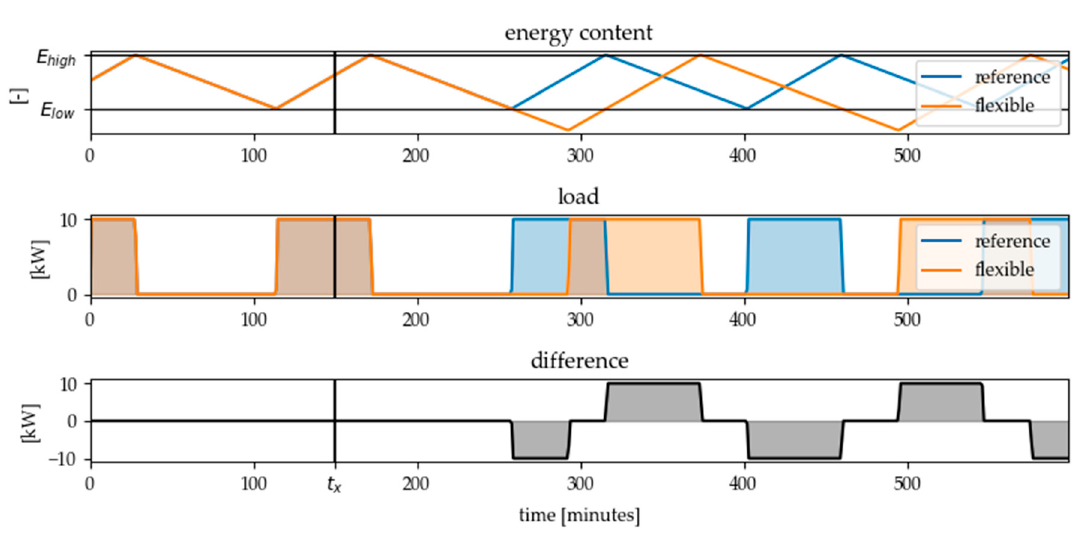
Figure 7. Resulting flexible load profile for a flexibility call of type HYST (adapting hysteresis limits) at time step t x = 150 and a desired load reduction ( d load = − 1) in comparison to the reference load profile without flexibility call.